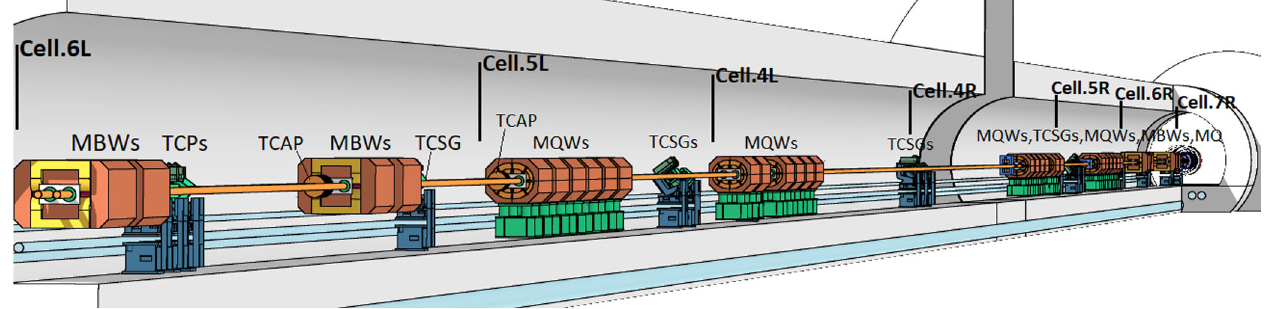
FIG. 1. FLUKA geometry model of the HE-LHC betatron cleaning insertion (warm section). The first object on the left is the MBW.D6L7 warm dipole, located 232 m upstream of the LSS center